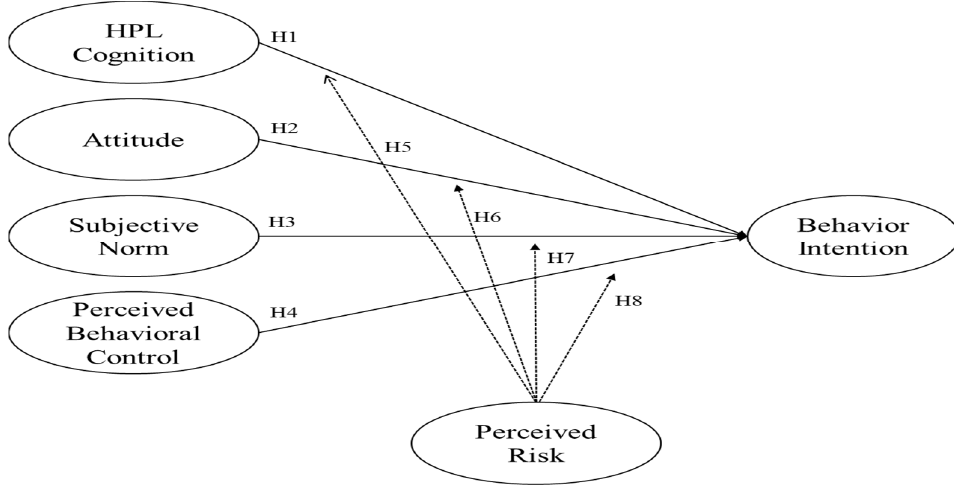
Figure 1. Research model.